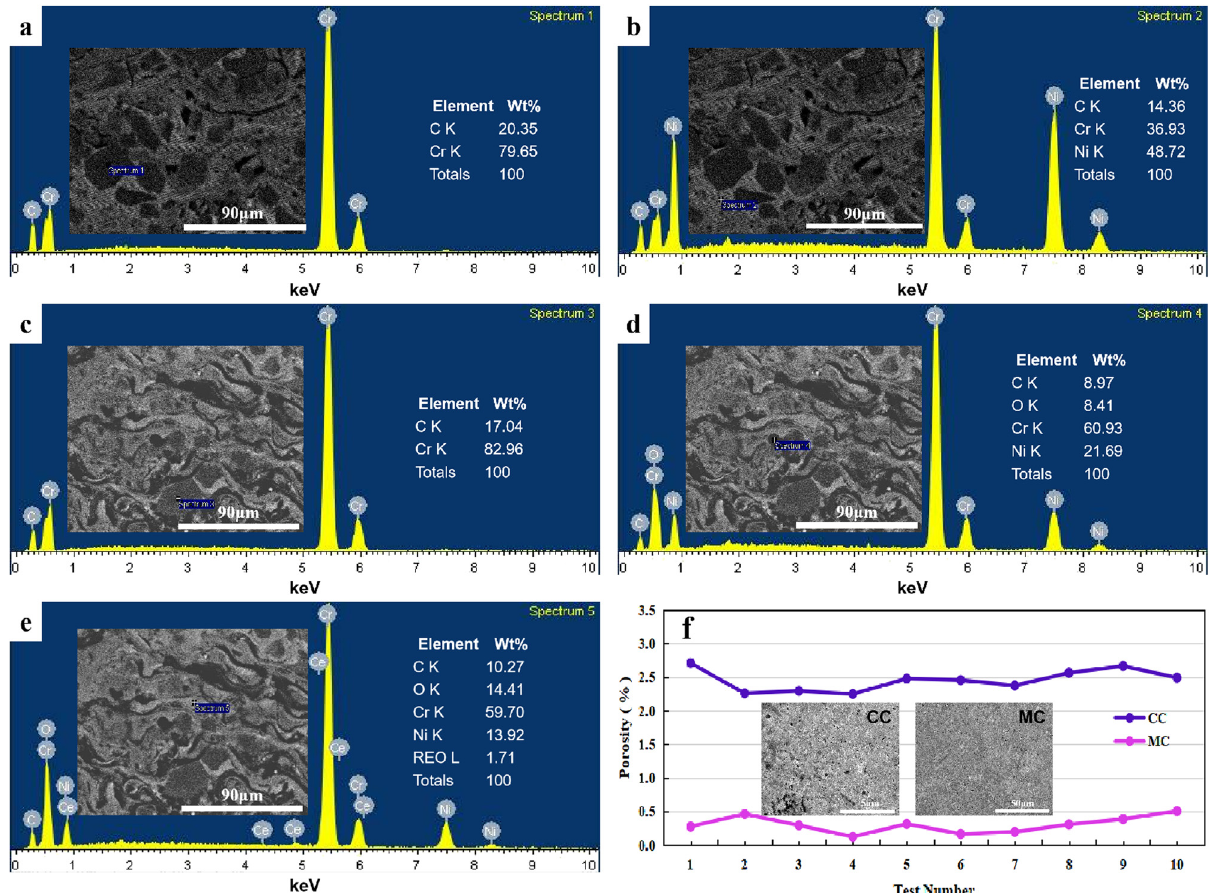
Figure 6: EDS spectra and porosity of the cross - sectional coatings: ( a and b ) EDS spectra of CC, ( c – e ) EDS spectra of MC, and ( f )